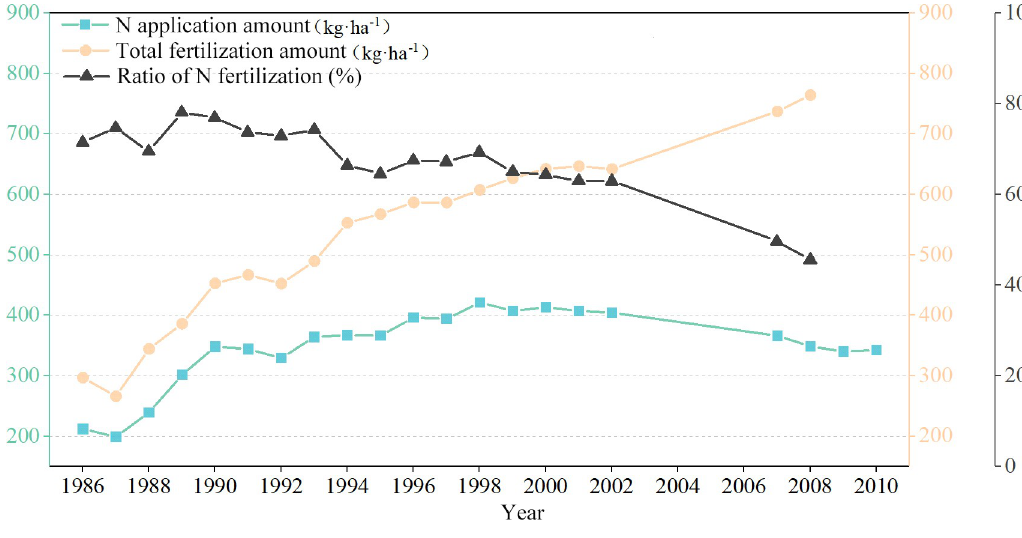
Fig 7. Interannual variation of fertilization